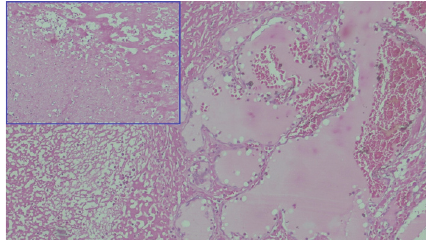
Figure 5: Tissue section showing areas of necrosis and adjacent thyroid follicles suggestive of tuberculosis of thyroid gland. Boxed area showing extensive areas of